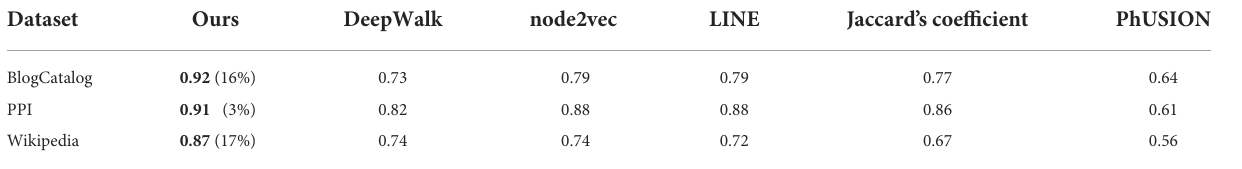
TABLE 3 Area under curve (AUC) scores for link prediction.